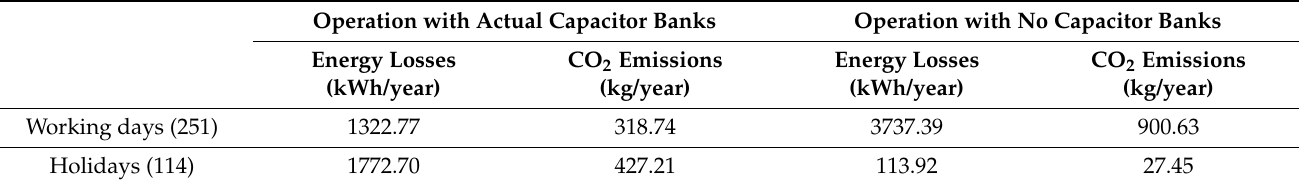
Table 5. Annual energy losses ( W cr ) and CO 2 emissions caused by reactive currents in the operation of the transformation house.